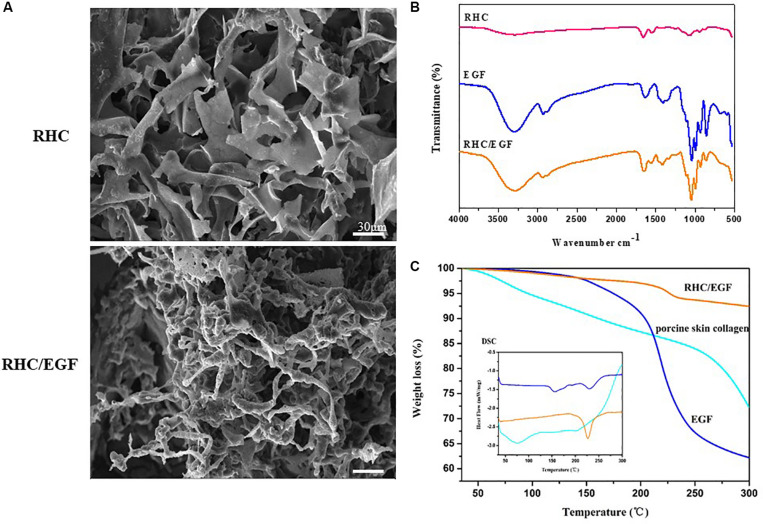
Characteristics of RHC and RHC/EGF. (A) Scanning electron micrographs of RHC and RHC/EGF freeze-dried dressings. (B) Fourier transform infrared spectra of RHC, EGF, and RHC/EGF freeze-dried dressings. (C) Differential scanning calorimetry spectrum of EGF, porcine skin collagen, RHC/EGF freeze-dried dressing.